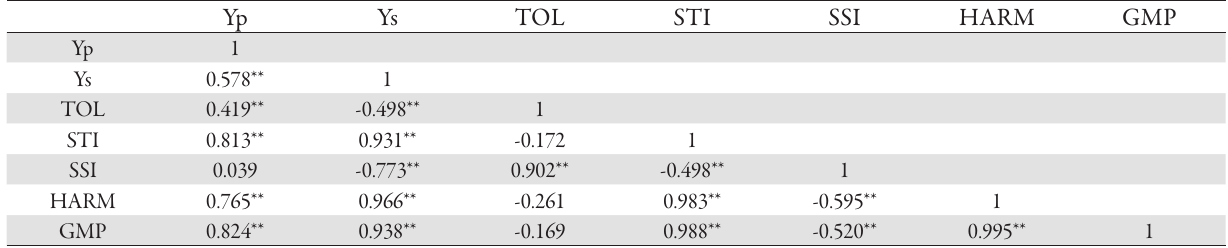
Tab. 4. Correlation coefficient between yield in 2/3 continuous irrigation stress level and drought tolerance indices Yp Ys